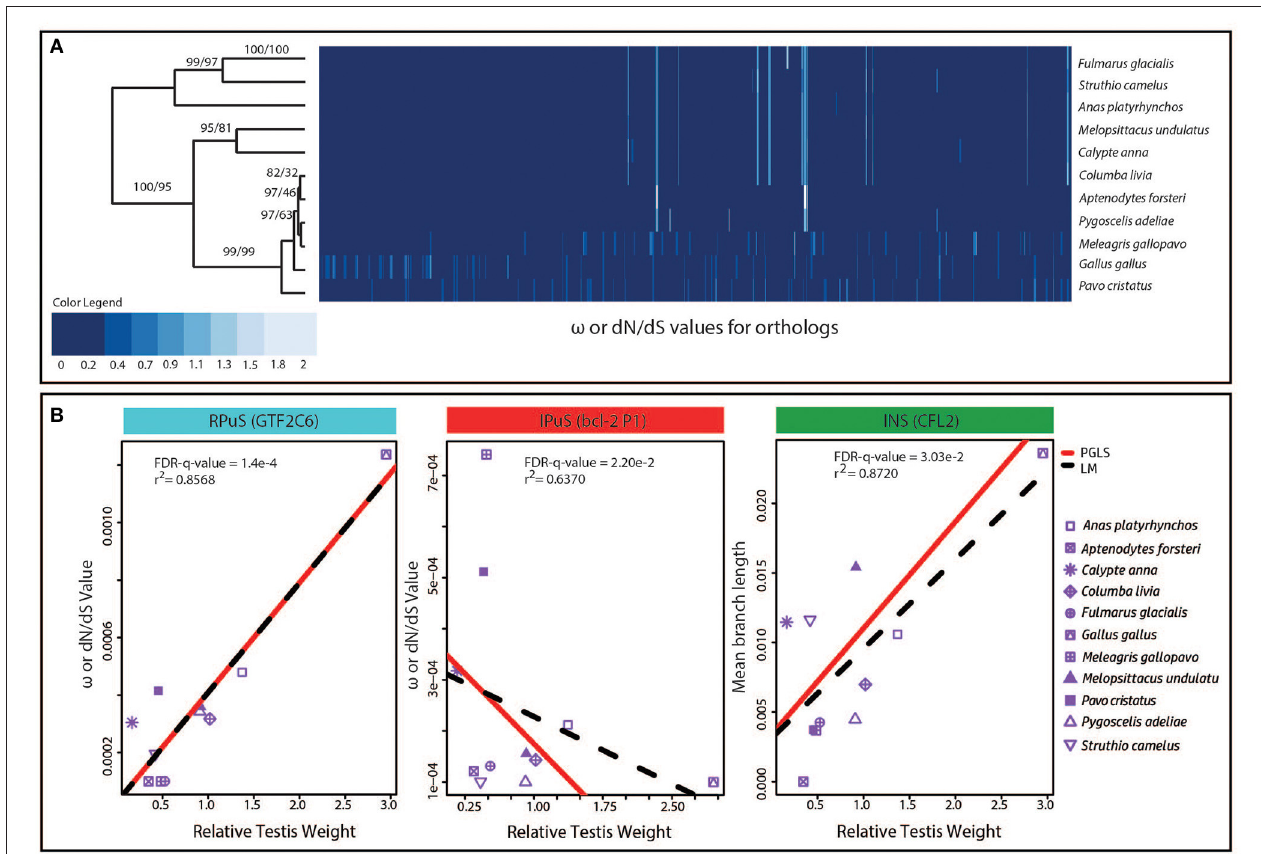
FIGURE 2 | The contribution of continuous or cyclic evolution model to the proximate mechanism of sexual selection. (A) Heatmap with hierarchical clustering of 11 species based on the absolute ω values for 577 genes which qualified the heterogeneity test and ω quality check criteria. The approximate unbiased p -values (AUp) calculated using multiscale bootstrap resampling, and bootstrap probability (BP) values calculated using normal bootstrap resampling are shown on respective branches as AUp/BP. (B) The scatter plot between ω values and relative testis weight for the three representative genes belonging to the RPuS, IPuS, and INS criteria that supports the continuous or ongoing model of sexual selection. The best fit lines from PGLS and linear model (LM) regression fit are shown